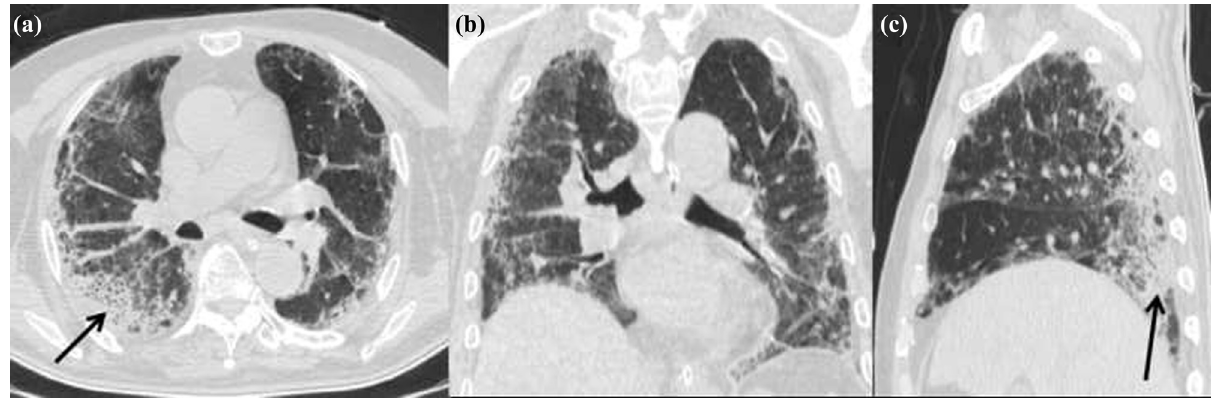
Figure 2: CT scans obtained 16 days after admission ( a: axial non - contrast CT image; b: coronal thin - section noncontrast CT image; and c: sagittal thin - section noncontrast CT image ) showing the range of lesions reduced compared with the previous images; partial patchy consolidation ( black arrows ) .